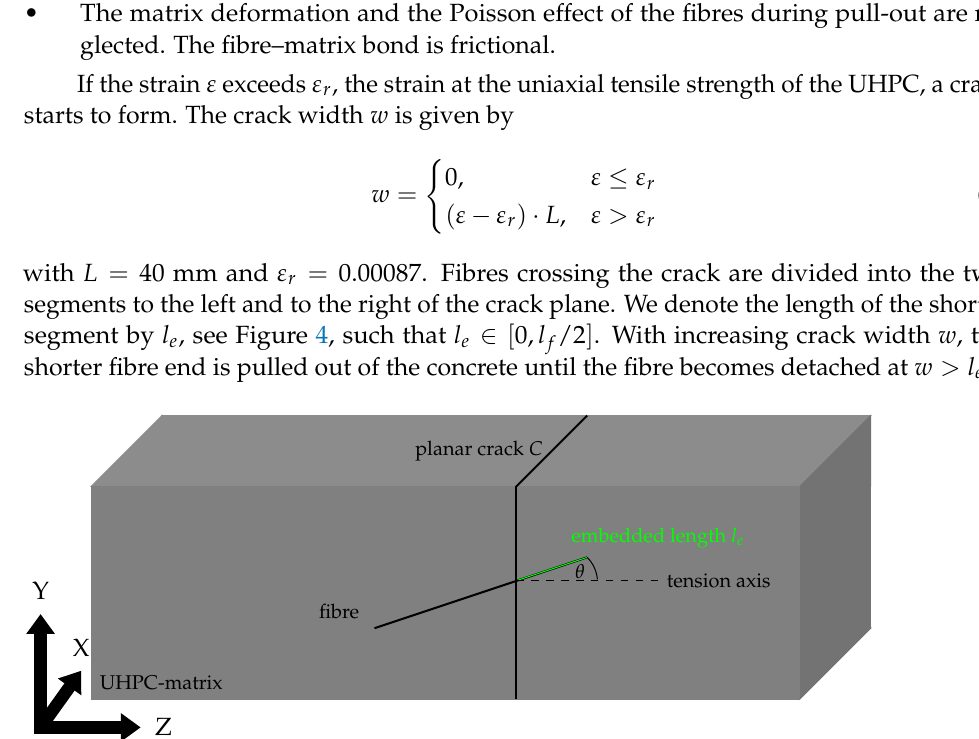
Figure 4. UHPC matrix with one fibre intersecting a planar crack C (assumed to be embedded in the (X,Y)-plane) at crack width w = 0. The crack divides the fibre in two parts. The embedded length l e is the length of the shorter (green) fibre part. The angle between fibre and tension axis (assumed to be the Z-axis) is denoted by θ